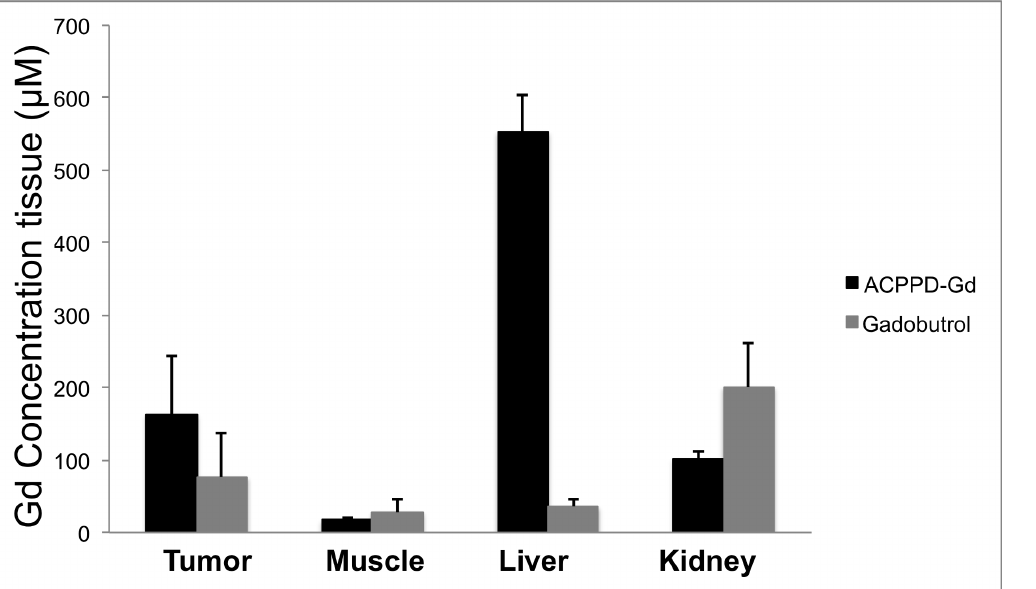
Fig 6. Tissue concentrations following ACPPD-Gd and gadobutrol. ACPPD-Gd resulted in significantly greater accumulation of Gd in tumors (163 ± 81 vs. 77 ± 60 μ mole Gd/mg tissue, p < 0.01) than gadobutrol and resulted in approximately 3.5 times greater tumor to muscle concentration ratio (9.3 ± 0.5 vs. 2.7 ± 1.0).